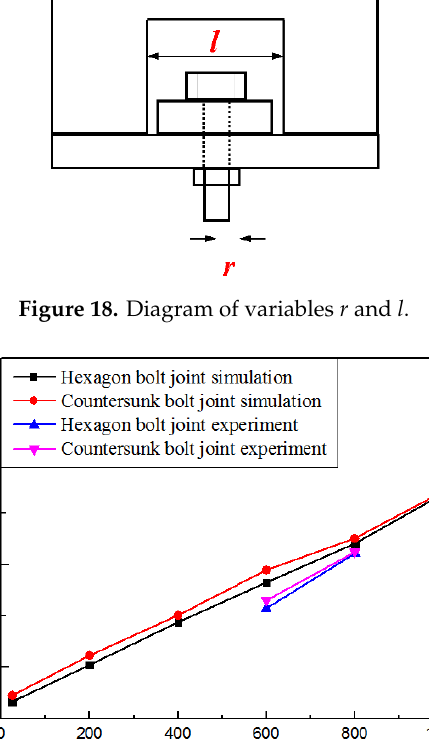
Figure 19. Evolution of the critical load with the temperature.